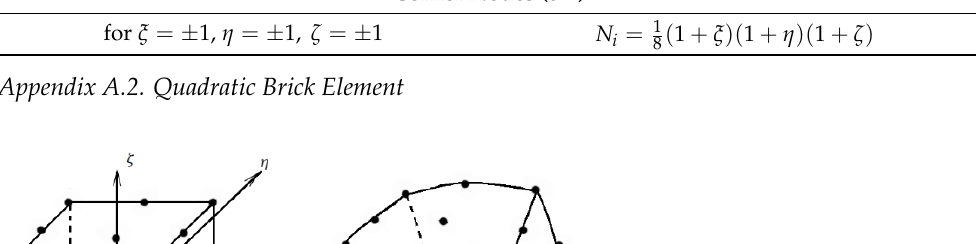
Figure A1. Cartesian global and local curvilinear coordinates of the 8-node brick FE. Table A1. The shape functions of the 8-node brick FE. Corner Nodes (8 × )